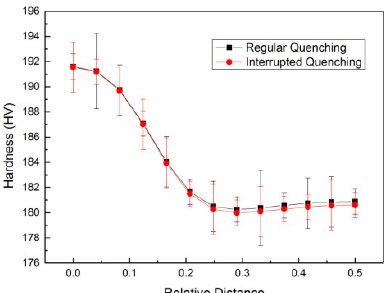
Figure 9. Comparisons of the hardness between regular quenching and interrupted quenching after T74 ageing treatment.